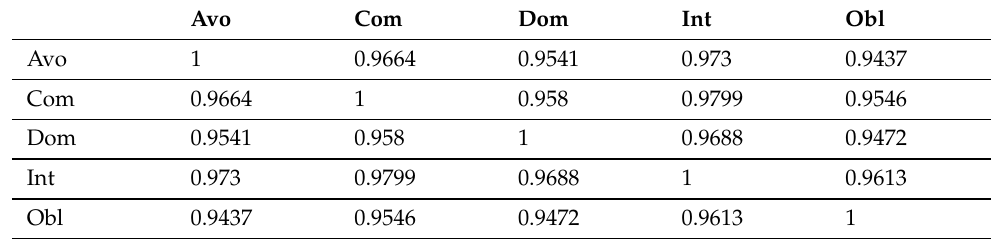
Table 10. Cosine similarity values between each of the TF-IDF matrices generated from the